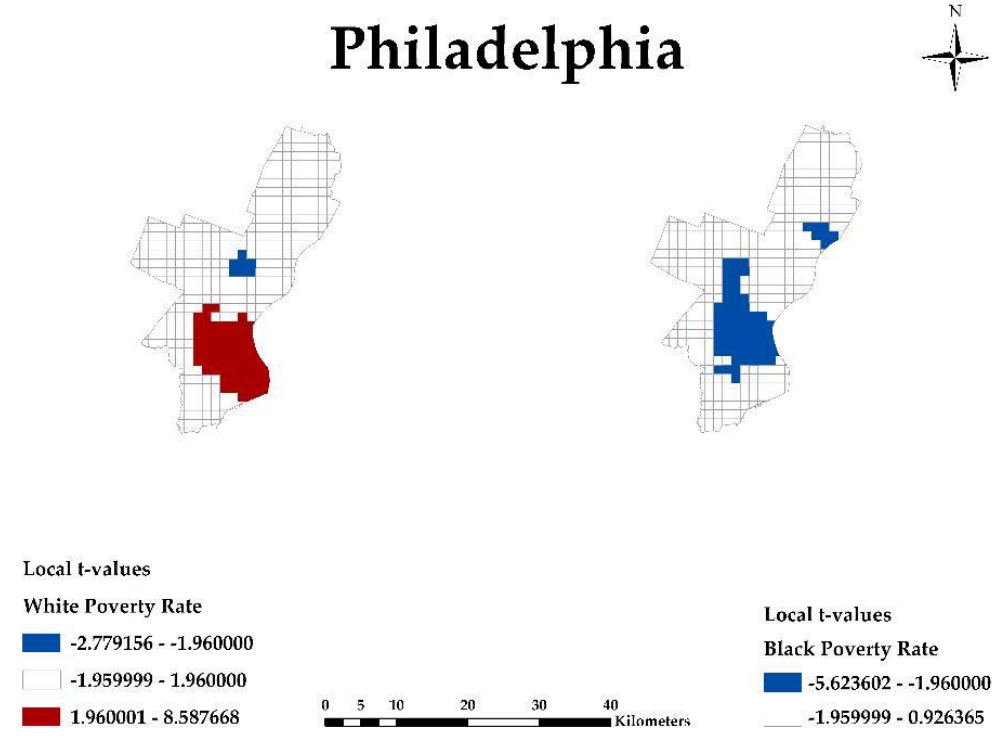
Figure 11. Philadelphia shrinking city White Poverty Rate and Black Poverty Rate: 95% two-tailed test (−1.96:1.96).